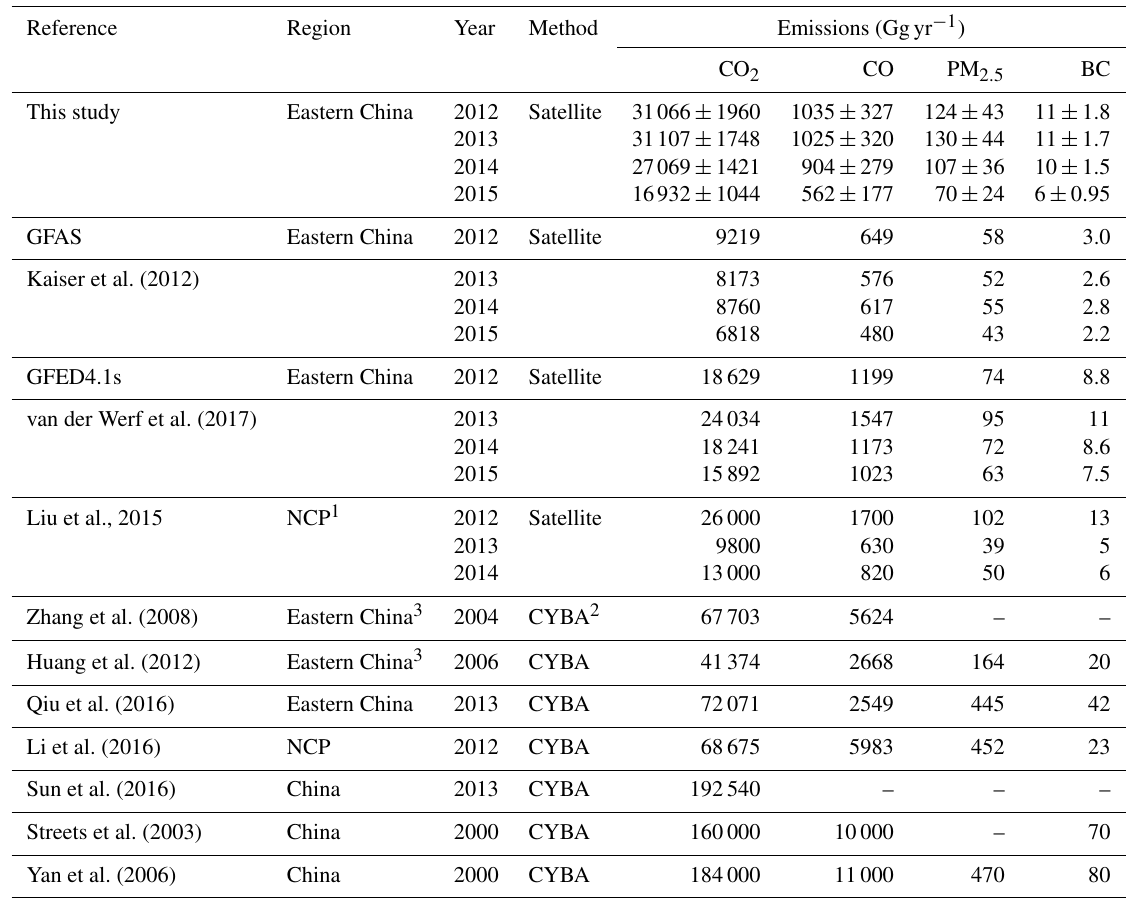
Table 2. Total species-specific fire emissions calculated in this study for agricultural burning in eastern China and a comparison to those contained within other fire emissions inventories and calculated in previous